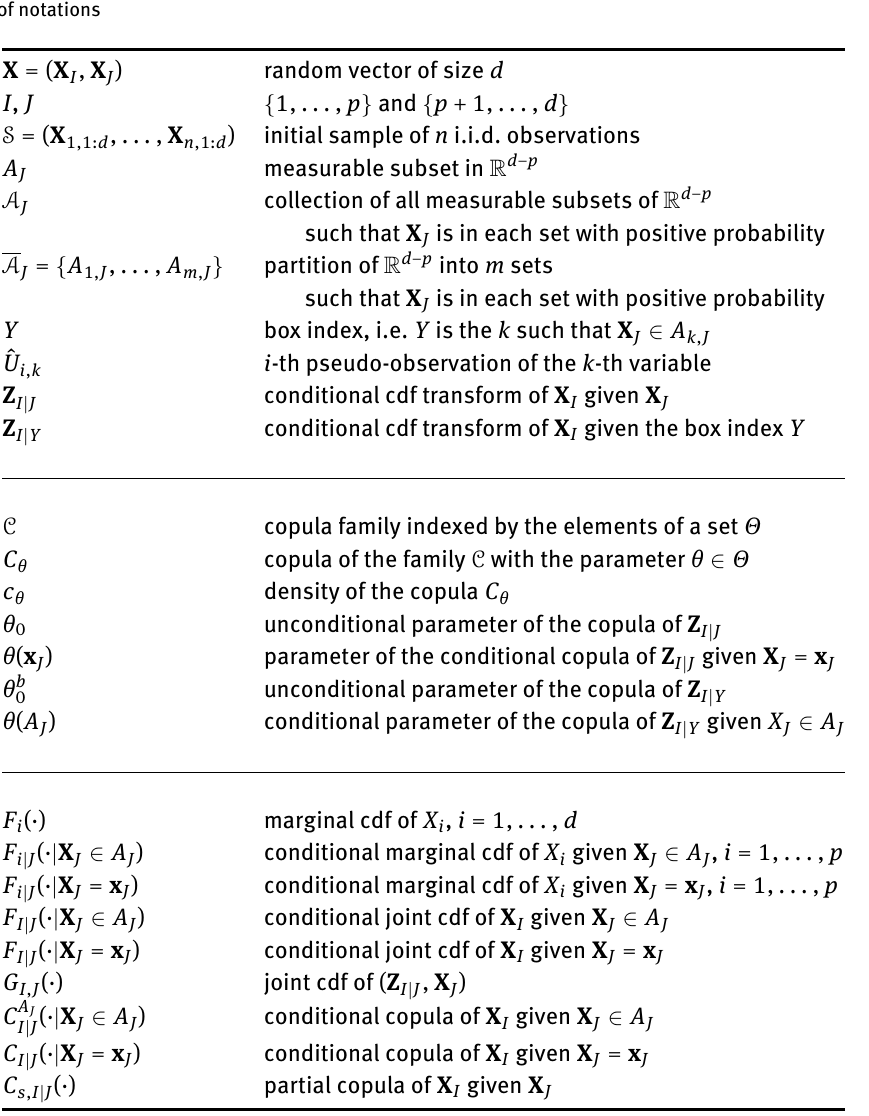
Table 5: Table of